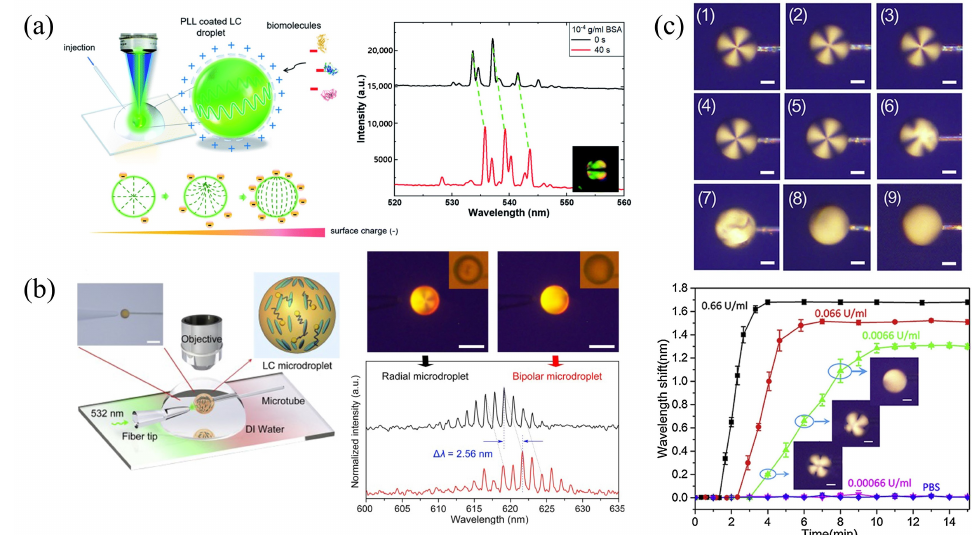
Figure 7. ( a ) Illustration of the experimental setup and the shift of the laser wavelength due to different concentrations of BSA [113]; reproduced with permission from Royal Society of Chemistry. ( b ) Schematic representation of the lasing experimental setup and wavelength shift of LC droplets with configuration transition from bipolar to radial [114]; reproduced with permission from Elsevier. ( c ) POM images of LC droplets in different concentrations of Myr and spectral responses at different concentrations of AChE [115]; reproduced with permission from